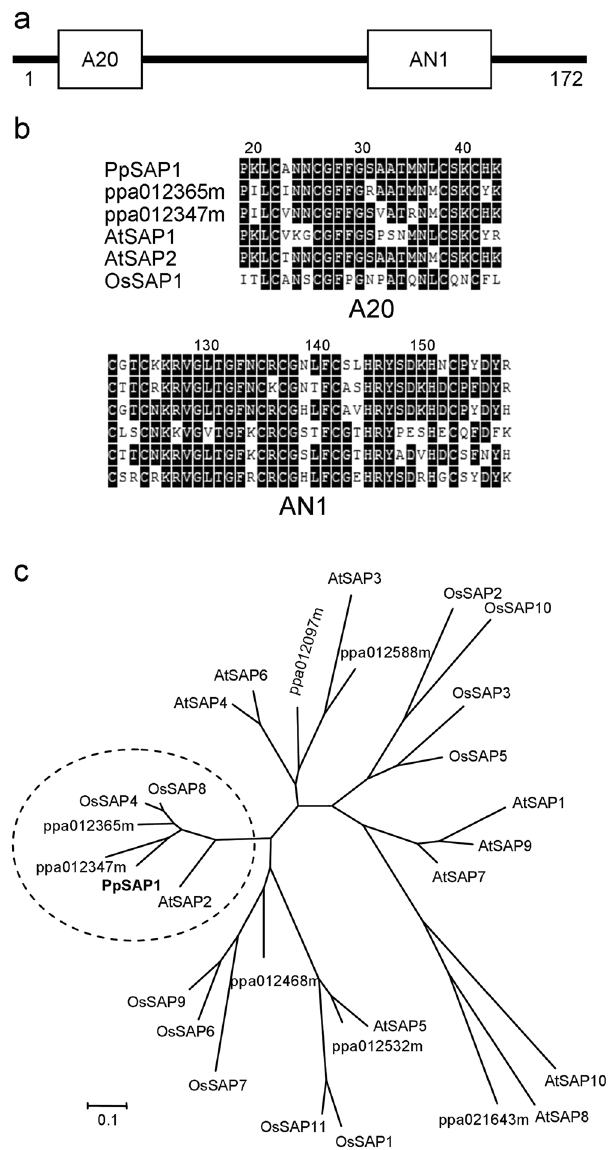
Figure 2. PpSAP1 is a stress-associated protein (SAP). Schematic representation of A20 and AN1 domains in PpSAP1 protein ( a ). Alignment of A20 and AN1 domains from PpSAP1 and other SAP-like proteins of peach, Arabidopsis and rice ( b ). In ( c ), phylogenetic tree of SAP proteins from Arabidopsis , rice and peach. The tree was constructed using the Maximum Likelihood method and bootstrapped with 1000 replicates. The scale bar indicates the branch length that corresponds to the number of substitutions per amino acid